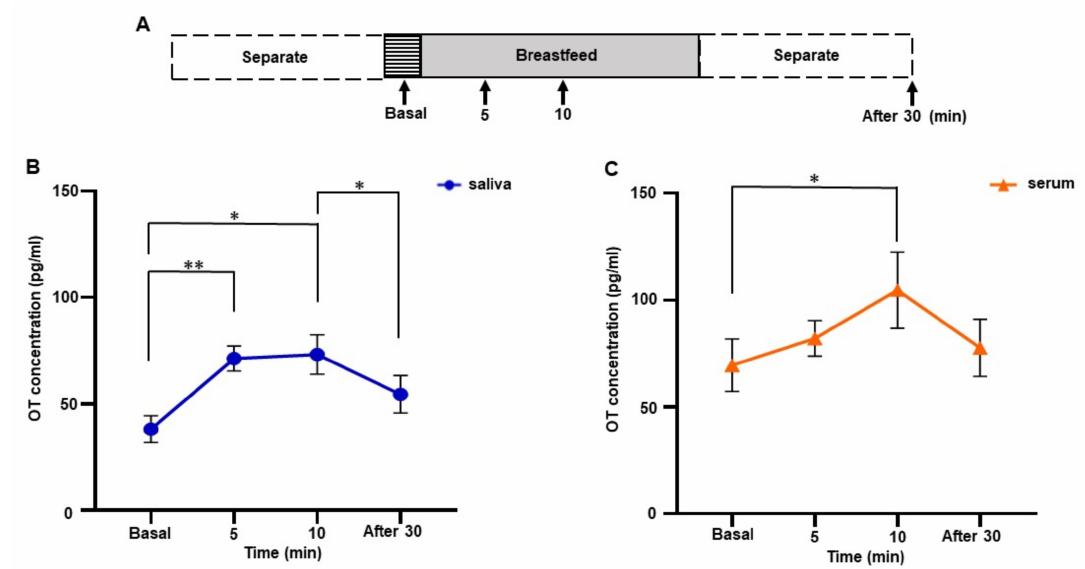
Figure 2. Changes in salivary and serum oxytocin (OT) concentrations during breastfeeding in one woman. ( A ) The time course of experiments. Samples were collected before (basal), 5, and 10 min after initiation of breastfeeding, and 30 min after feeding ended. Values were averaged from samples taken on postpartum days 1, 3, 5, 7, 30, and 90. ( B ) Salivary OT concentration. ( C ) Serum OT concentration. The experiment was repeated six times with one mother (n = 6). The values are the mean ± SEM. OT: oxytocin. One-way repeated measures ANOVA (d.f. = 3; * p < 0.05 ** p < 0.01).